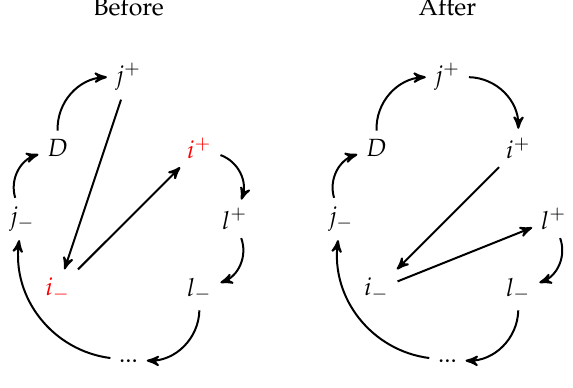
Figure 2. Repair-Destroy Node (RDN).